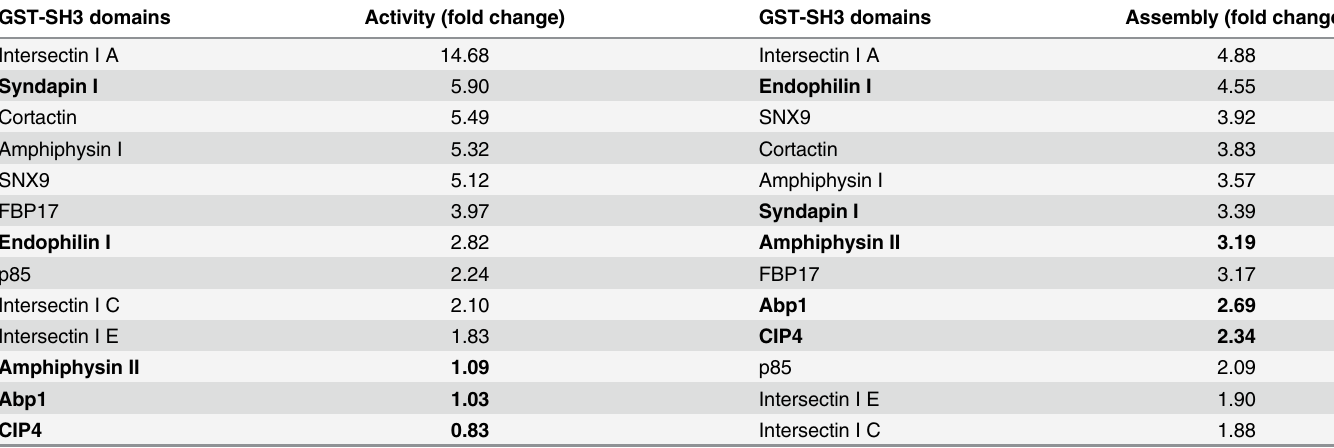
The GST-SH3 domains are listed in descending order of their stimulatory effect on endogenous sheep brain dynamin I activity and assembly under low salt conditions. Both parameters are represented as fold change relative to dynamin basal (no SH3) control. Those exhibiting poor correlation between activity and assembly are indicated in